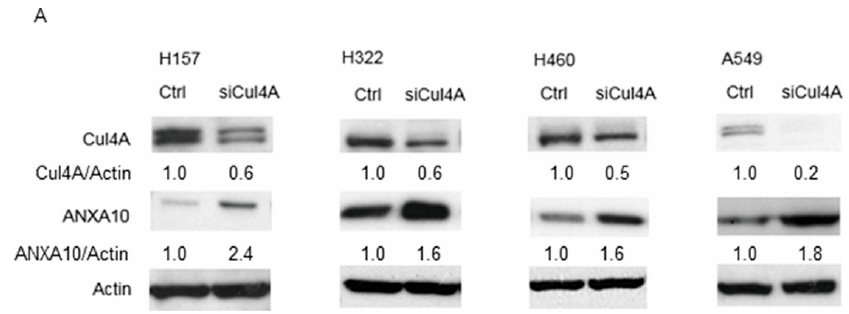
Figure 2. Cont . Figure 2.